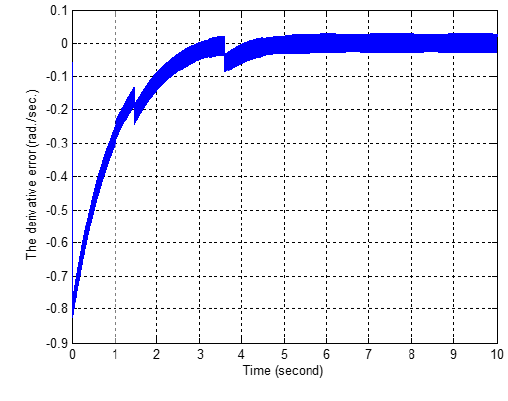
Fig. 8. The derivative error CSMC.